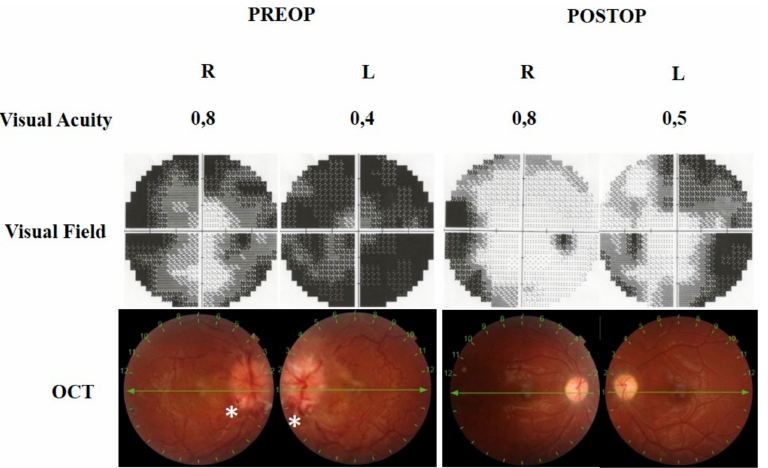
Figure 5. The 21-year-old male patient (Case 8) presented with headaches and progressive visual impairment. The visual field showed severe bilateral constriction of visual field defect with a general reduction in sensitivity. There was also severe bilateral papilledema with optic disc hemorrhages (*) and retinal vein engorgements, choroidal folds, and retinal edema. One month following EOND, the visual field defects improved, retinal hemorrhages disappeared, and edema noticeably